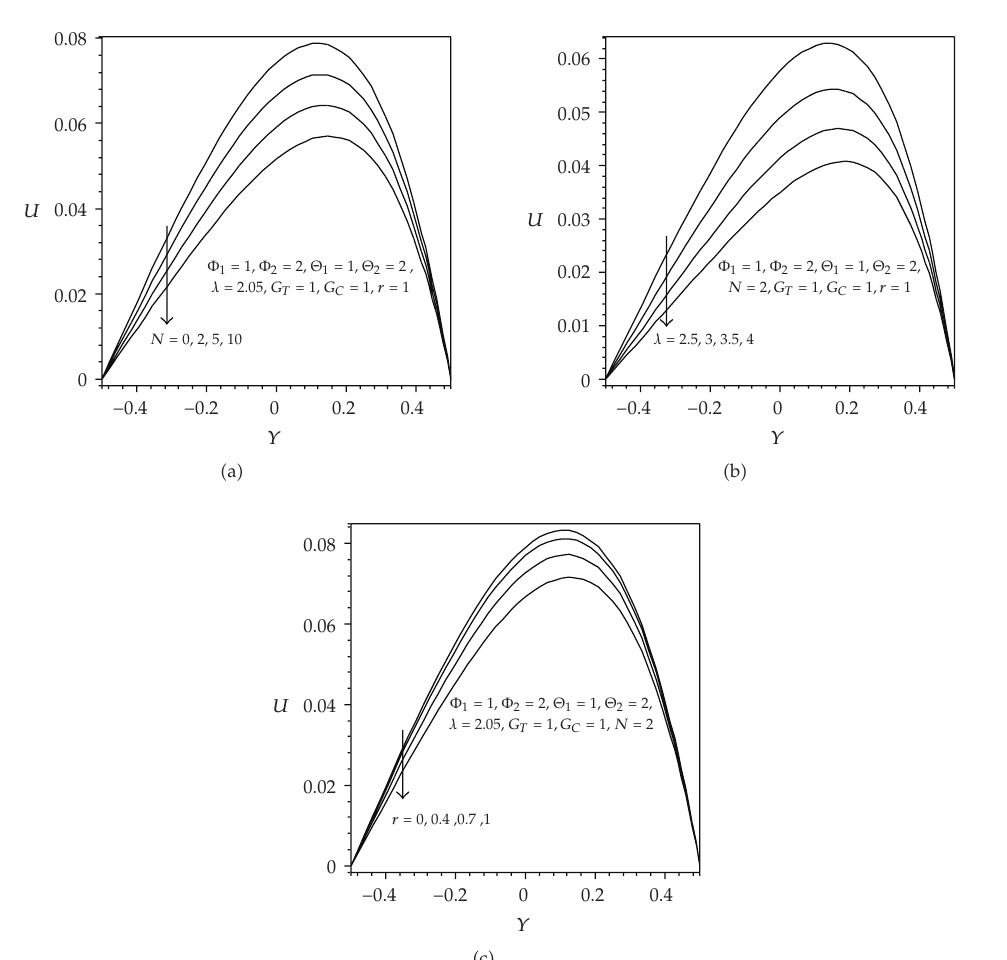
Figure 6: Velocity profiles as a function of Y for variations in the parameters: (cid:5) a (cid:6) Radiation, N ; (cid:5) b (cid:6) magnetic-porosity, r ; (cid:5) c (cid:6) reaction-rate, r